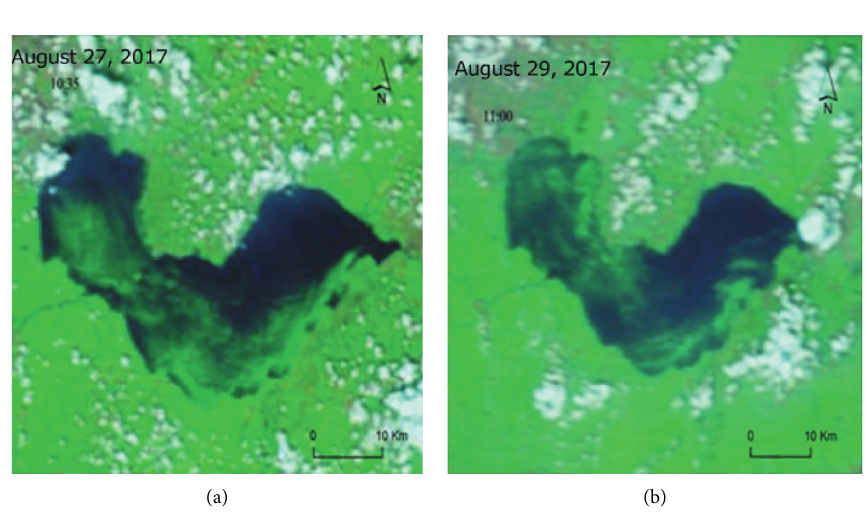
Figure 3: Sensing image of cyanobacterial pollutant diffusion in Chaohu lake (excerpt).